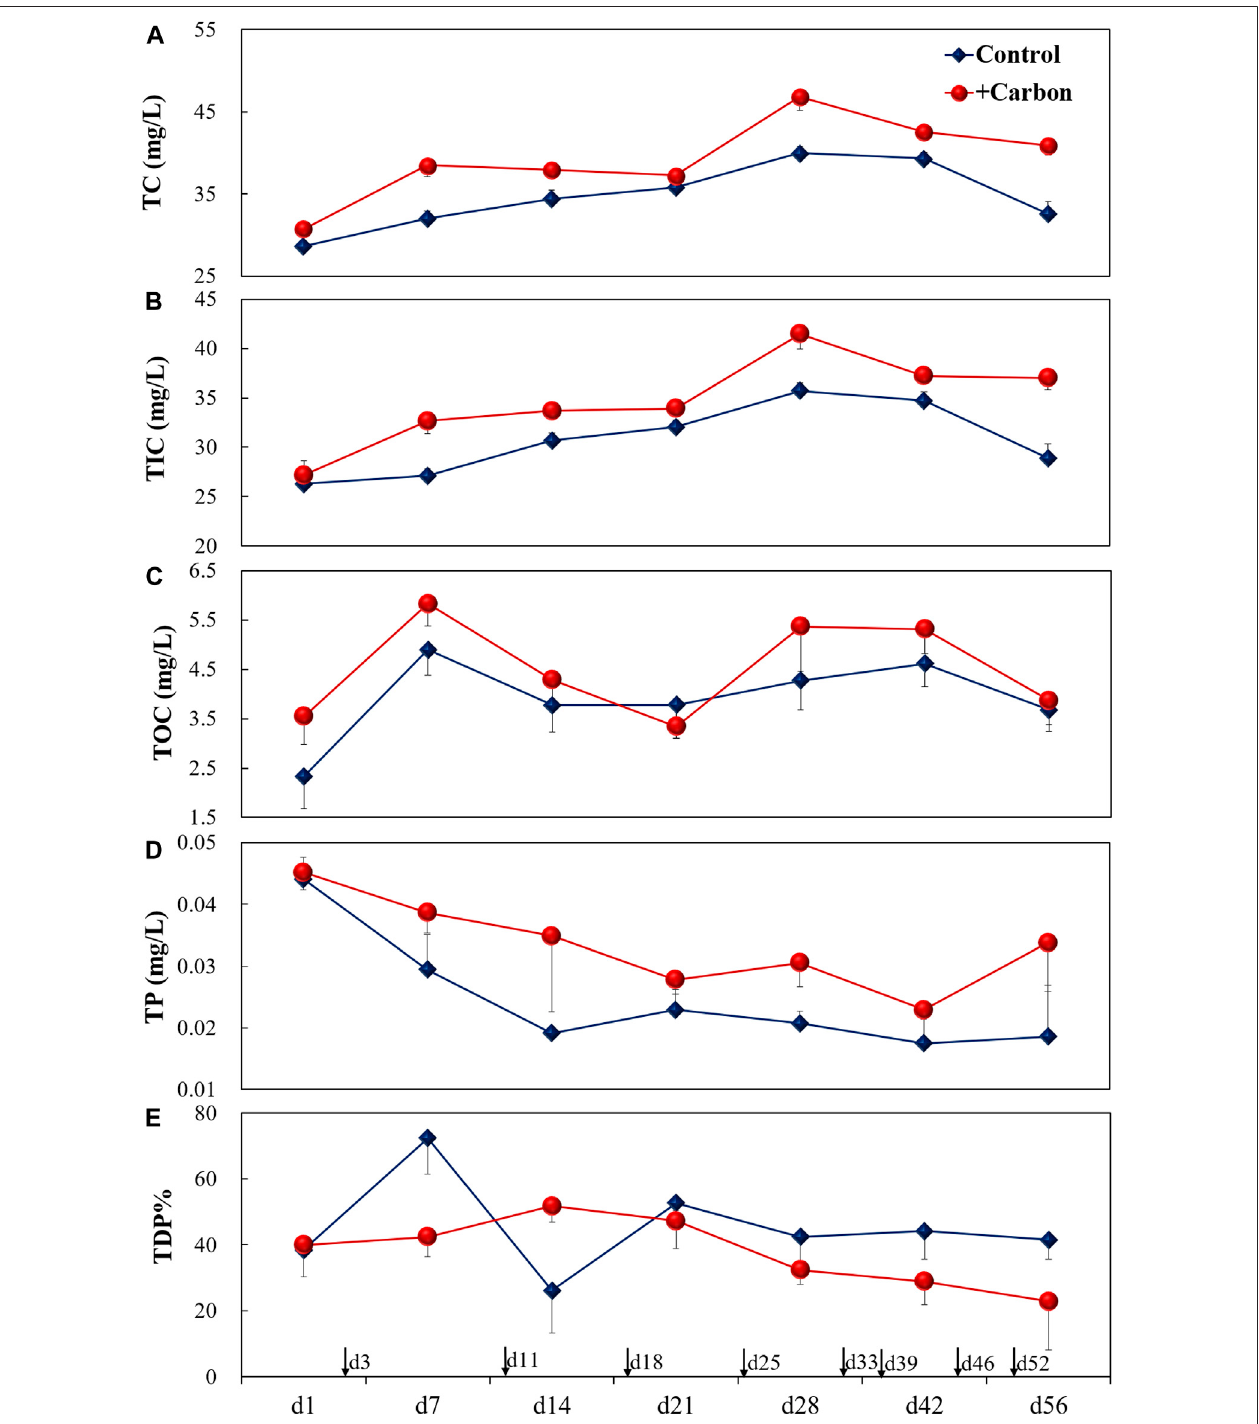
FIGURE 1 | Changes (mean ± SE) in TC (A) , TIC (B) , TOC (C) , TP (D) , and TDP% (E) for various treatments during the experiment. Single-headed arrows indicate the time of carbon addition. TC, total carbon (mg L − 1 ); TIC, total inorganic carbon (mg L − 1 ); TOC, total organic carbon (mg L − 1 ); TP, total phosphorus (mg L − 1 ); TDP%, total dissolved phosphorus contribution to TP; Control, control treatment without carbon addition; +Carbon, carbon addition treatment (equivalent to 5 mg C L − 1 ).